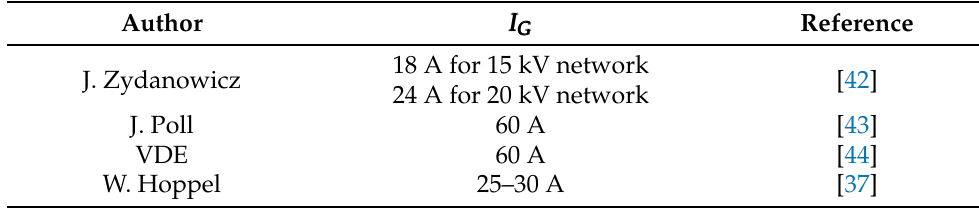
Table 1. Values of self-extinguishing current limit.